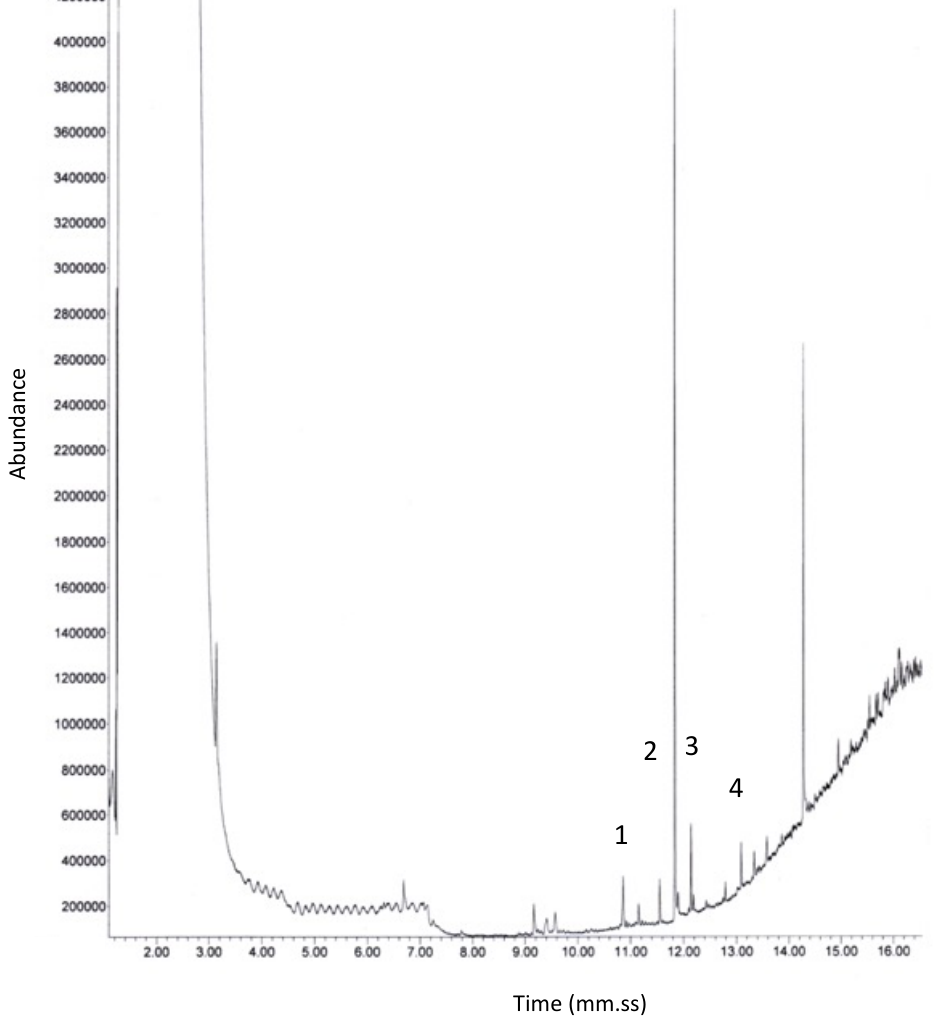
Figure 9. GC-MS chromatogram (fused-silica capillary column, HP-5MS; stationary phase SE54; 30 m × 0.25 mm I.D. and 0.25 µ m d f ; T inj 300 ◦ C; splitless mode 30 s; T transfer line 200 ◦ C; program: T 0 120 ◦ C, isothermal for 1 min, 30 ◦ C min − 1 up to 200 ◦ C, 5 ◦ C min − 1 up 230 ◦ C, then 30 ◦ C min − 1 up to T final 290 ◦ C; carrier gas He; m/z from 50 to 700 at 70 eV.) of a pavement sample. Peaks: 1 hexadecane, 2 octadecane, 3 nonyl 2-propyl ester sulfurous acid, 4 tributylchloro-stannane. Mass spectra are shown in Figure S4 of the Supplementary Material.